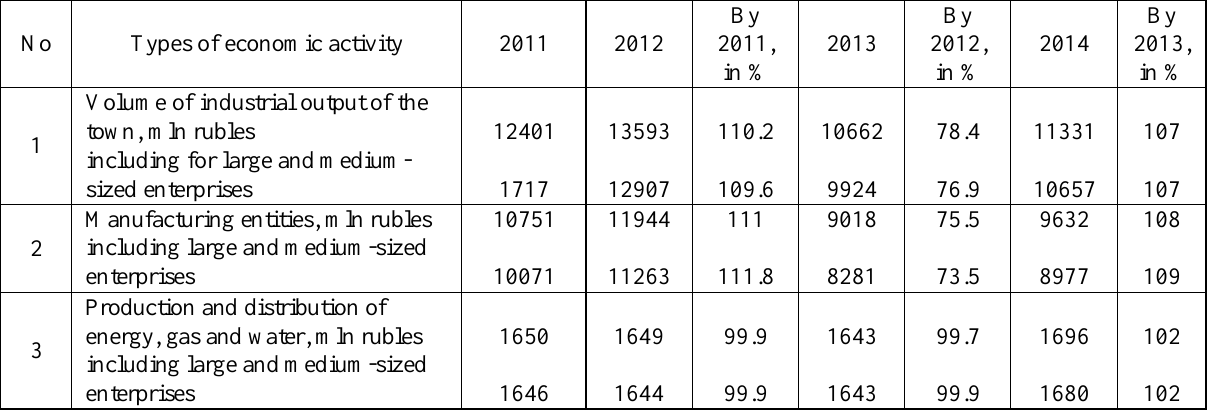
Table 1. Changes in industrial output of municipal formation “Yurginsky Municipal District”